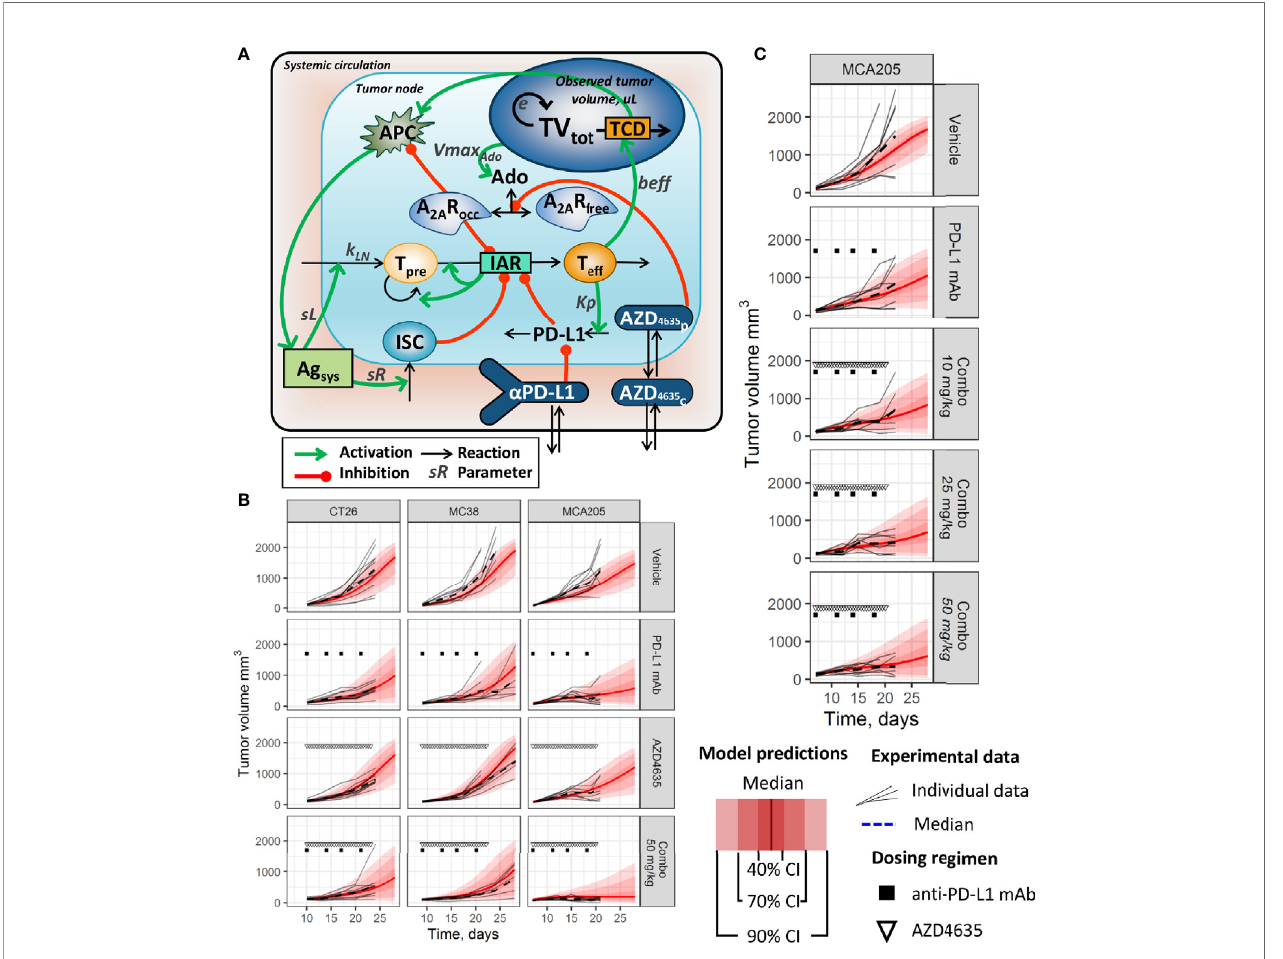
FIGURE 1 | (A) Simpli fi ed model schematic. Abbreviations used: Ado, adenosine level; A 2A R, unbound A 2A R level; A 2A Rocc, occupied A 2A R level; Agsys, systemic level of tumor antigen; AZD4635c, AZD4635 concentration in central compartment; AZD4635p, AZD4635 concentration in peripheral compartment; IAR, immune activation rate; ISC, component of immunosuppressive cells in TME; PD-L1, PD-L1 immunosuppressive component in TME; a PD-L1, an anti-PD-L1 mAb level in central compartment; nTeff, non-differentiated T-cells; dTeff, cytotoxic effector T-cells; TCD, tumor cell death; TVtot, total tumor volume. (B, C) Distributions of population model predictions and corresponding tumor size dynamics data from (B) ef fi cacy studies in CT26, MC38, and MCA205 syngeneic models (dosing regimen: 5 mg/kg anti-PD-L1 mAb BW; 50 mg/kg AZD4635 BID). (C) A dose- fi nding study in MCA205 syngeneic model (dosing regimen: 5 mg/kg anti-PD-L1 mAb BW; 10 – 50 mg/kg AZD4635